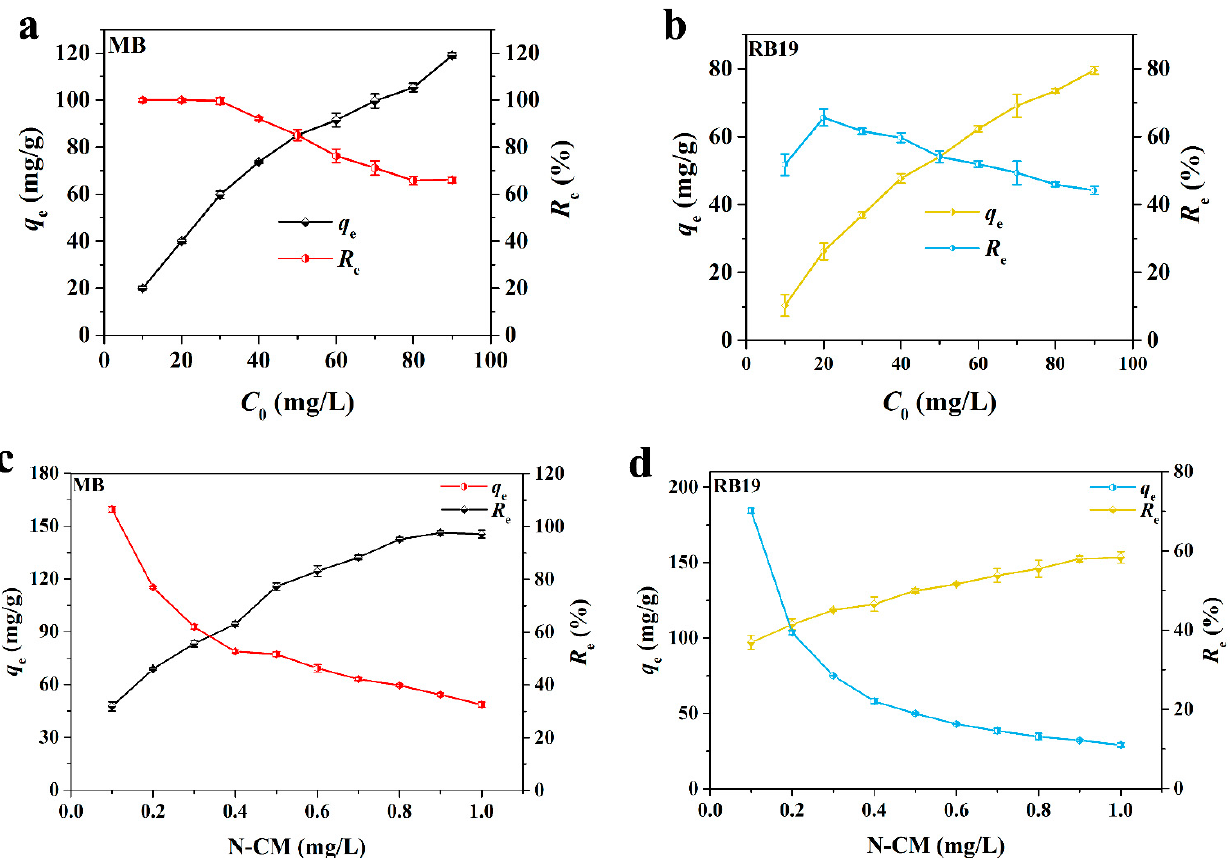
Figure 4. Effect of initial dye concentration on ( a ) MB and ( b ) RB19 adsorption onto N ‐ CM. Effect of N ‐ CM dosage on ( c ) MB and ( d ) RB19 adsorption. (in natural pH aqueous solution at 25 °C for 72 h).